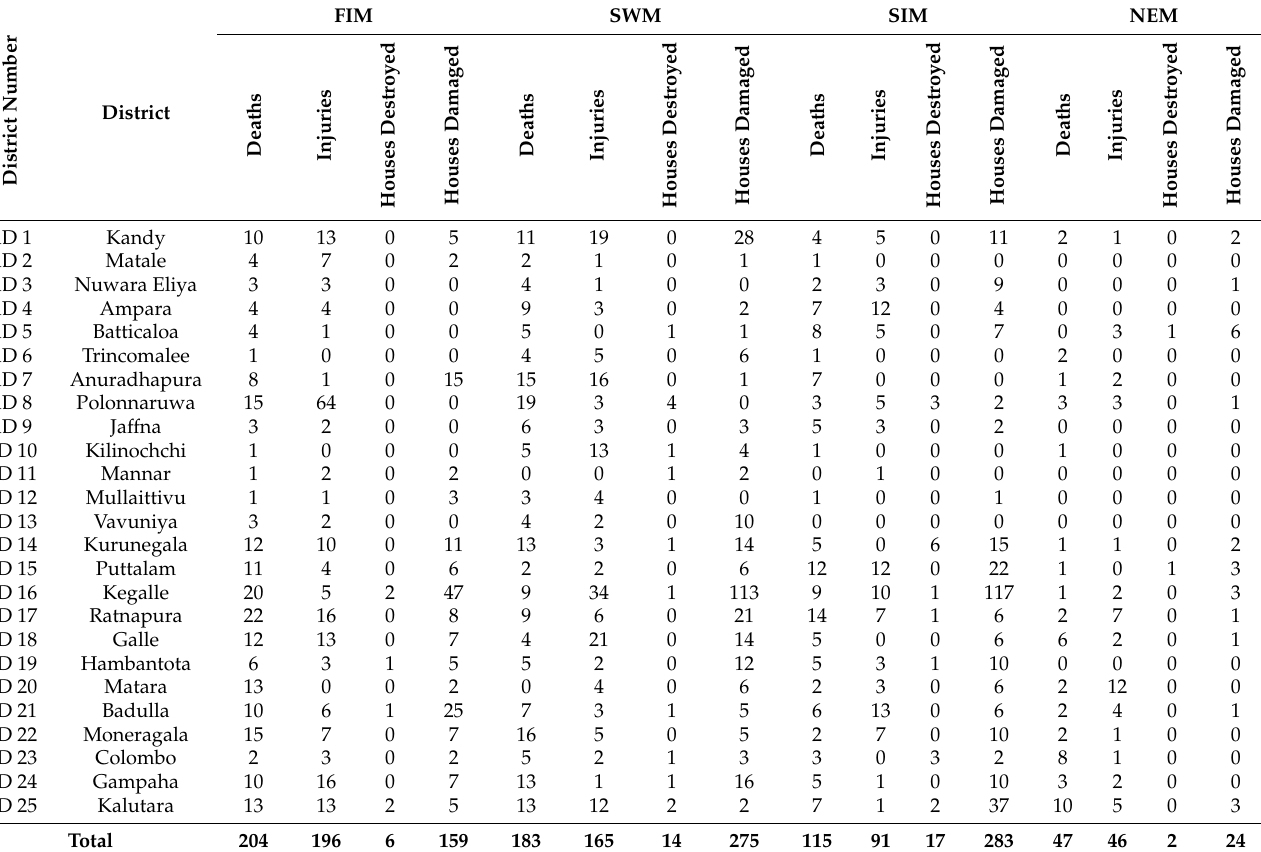
Table 1. Lightning accidents in the administrative districts of Sri Lanka for all four climate seasons, from 1974 to 2019.